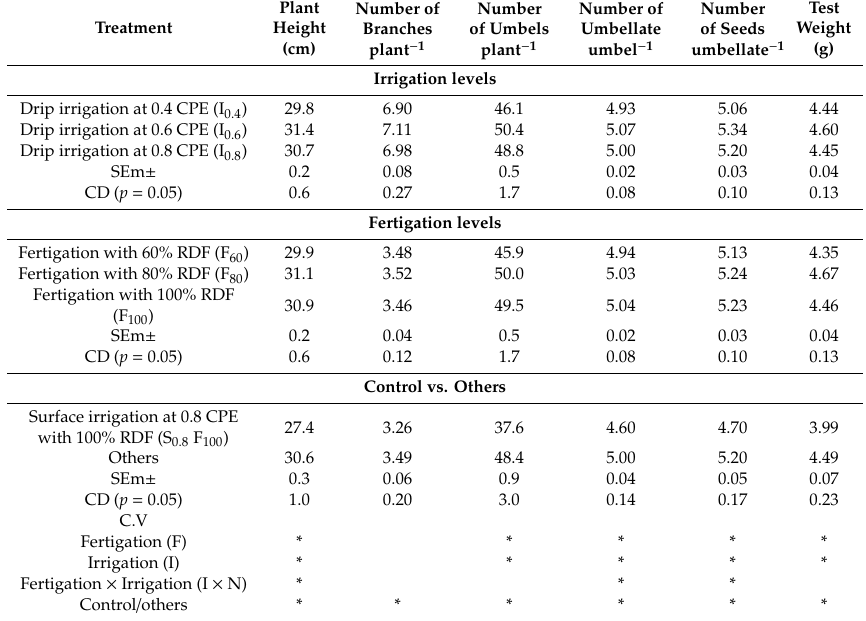
Table 1. E ff ect of drip irrigation and fertigation levels on the growth and yield attributes of cumin (pooled data of three